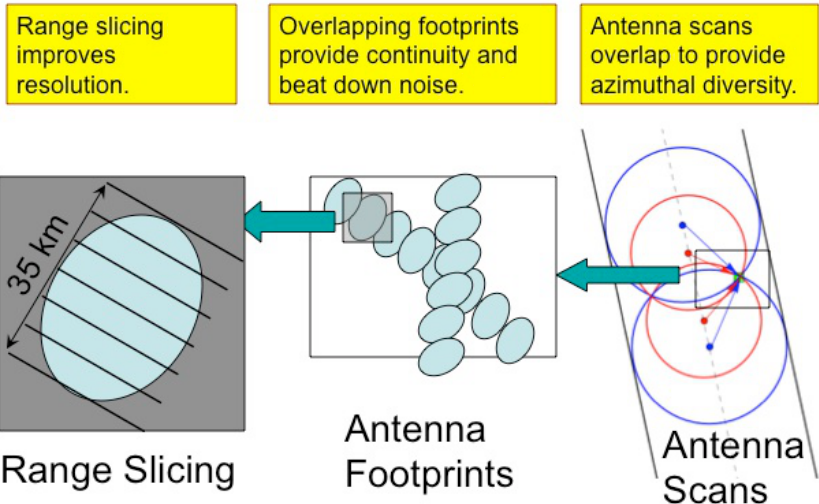
Figure 2. QuikSCAT Measurement Geometry. The geometry is shown on three scales. On the left, the smallest scale illustrates the spatial extent for the measurements (about 8 km by 25 km range slices) obtained during a single radar observation. Range slices are produced by breaking up the energy received by the radar into range-to-target bins. The middle panel shows multiple observations (footprints) obtained by the spinning antenna. The rightmost panel shows a portion of the pattern inscribed on the ground by the two rotating antenna beams. The blue circles are two rotations of the outer 54-degree incidence angle beam, and the red circles are rotations of the inner 46-degree incidence angle beam. The dots at the center of each circle are the location of the spacecraft in its orbit when that circle was inscribed. The black rectangle illustrates where measurements from four different azimuths (arrows) overlap. Measurements from different azimuths are required to retrieve wind direction and speed.